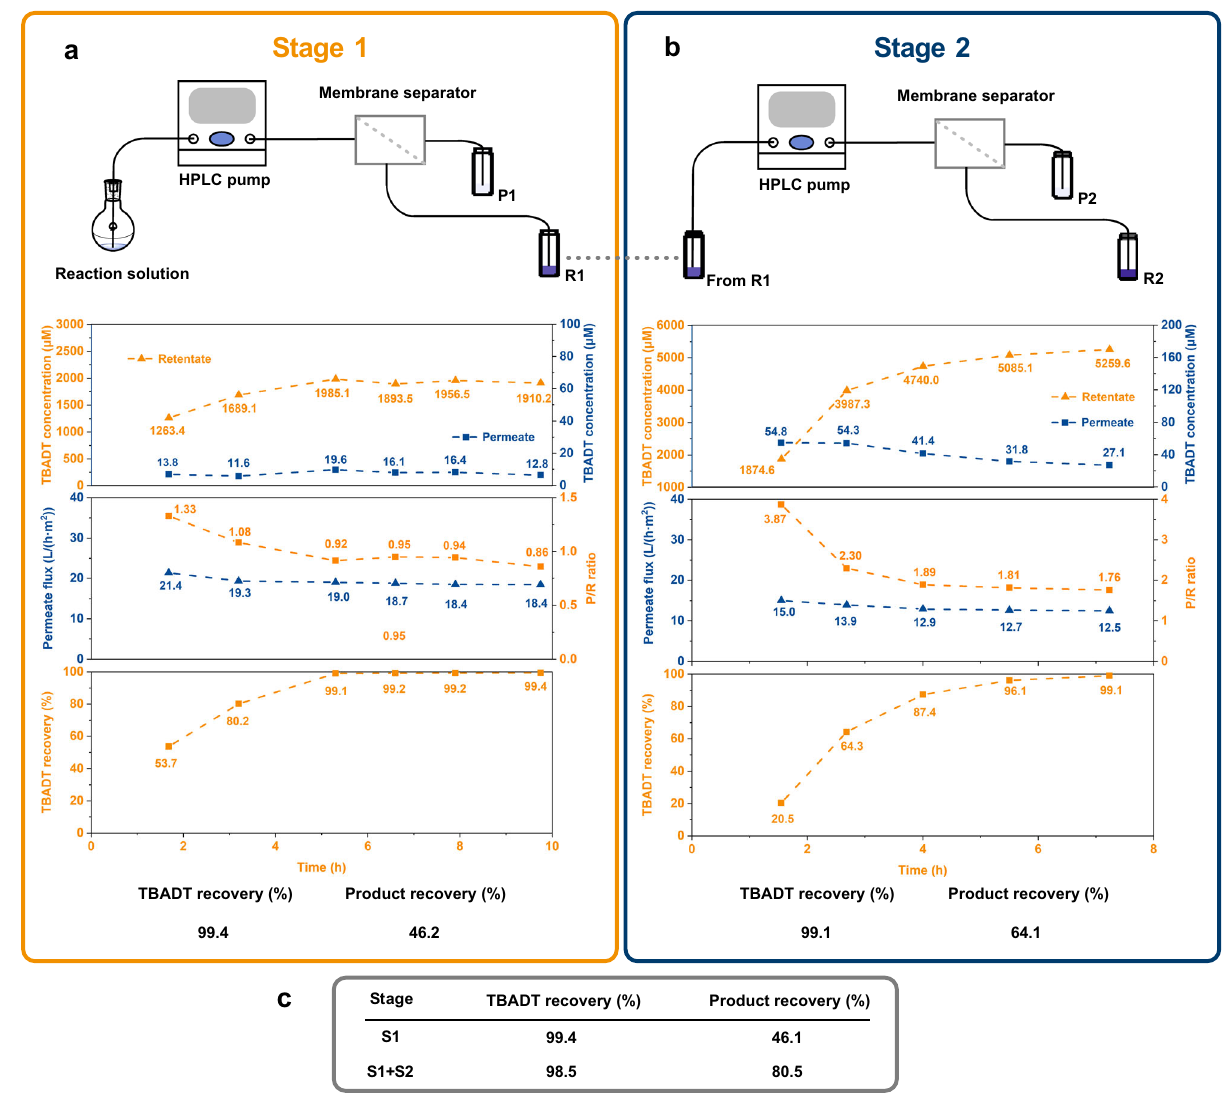
Fig. 3 | OSN performance investigation with a photocatalytic hydroalkylation reaction. a Results of the nano fi ltration experiment of the reacted mixture (Stage 1): concentration of TBADT in the retentate (R) and permeate (P); permeate fl ux; catalyst and product recovery. b Results of the nano fi ltration experiment of the